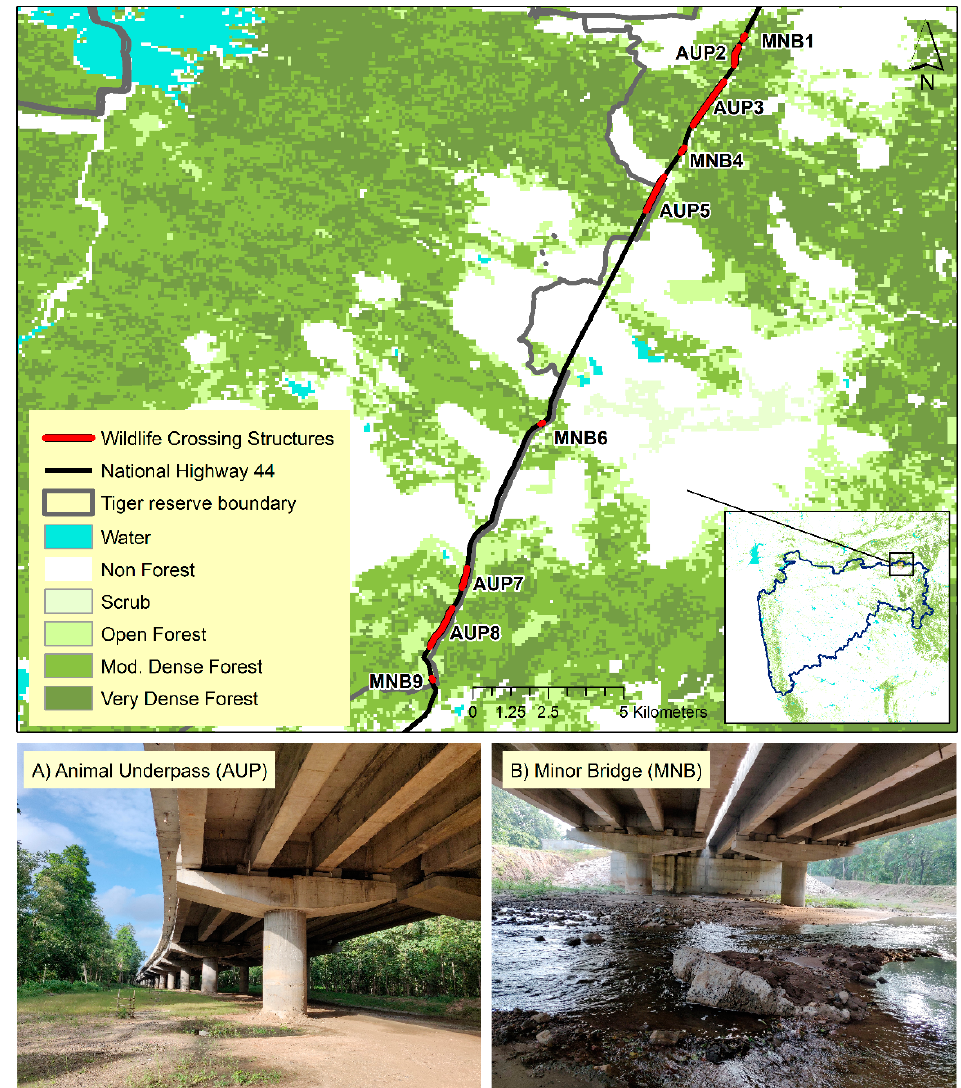
Figure 1. Location of nine crossing structures on National Highway 44 passing through Pench Tiger reserve, Maharashtra (top): ( A ) a typical animal underpass (AUP), and ( B ) a typical minor bridge (MNB).